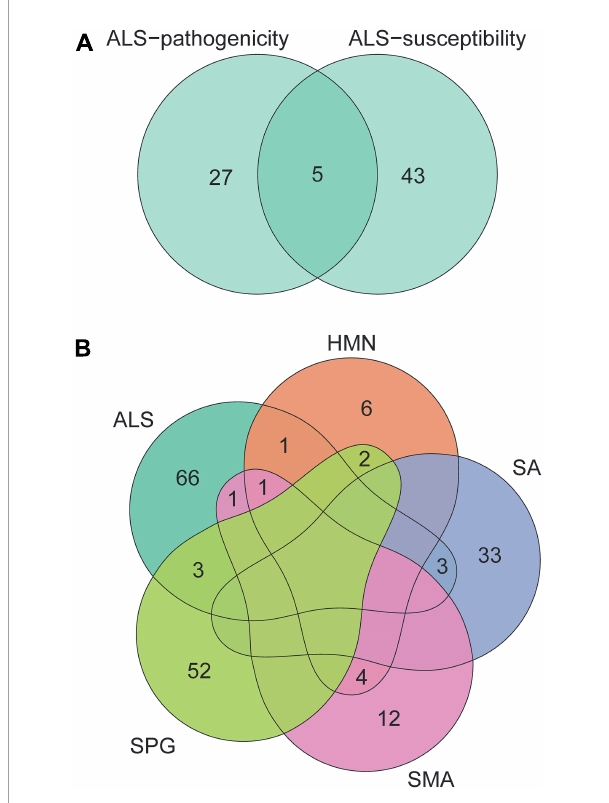
FIGURE1 Venn diagram of genes related to ALS, HMN, SA, SPG, and SMA. The numbers in the area show the gene number in the corresponding overlap of genes related to ALS-pathogenicity and ALS-susceptibility (A) , genes related to ALS, HMN, SA, SPG, and SMA (B) . These neurological disorders with complex phenotypic overlaps share few genes.